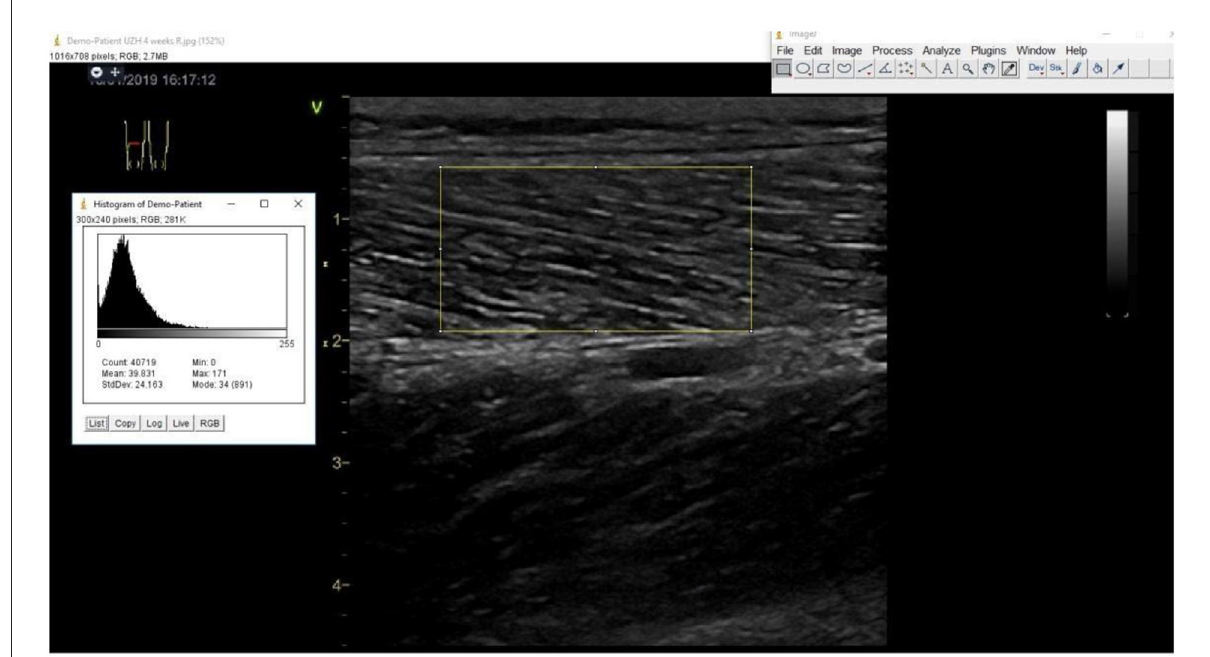
FIGURE4 Measurement of echogenicity of the right vastus lateralis muscle using Image J